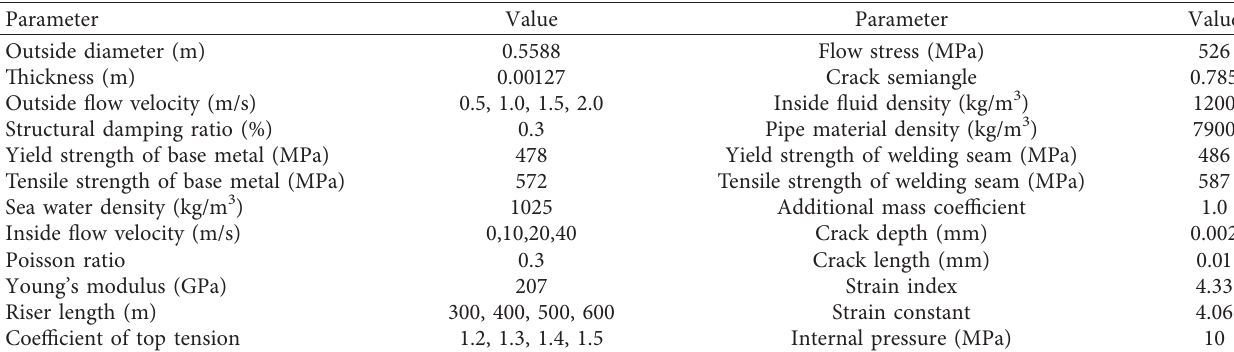
Figure 4: Verification diagram of RMS distribution of riser displacement with reduced velocity of 41.12: (a) CF; (b) IL. Table 2: Properties and size parameters of X65 material for pipeline